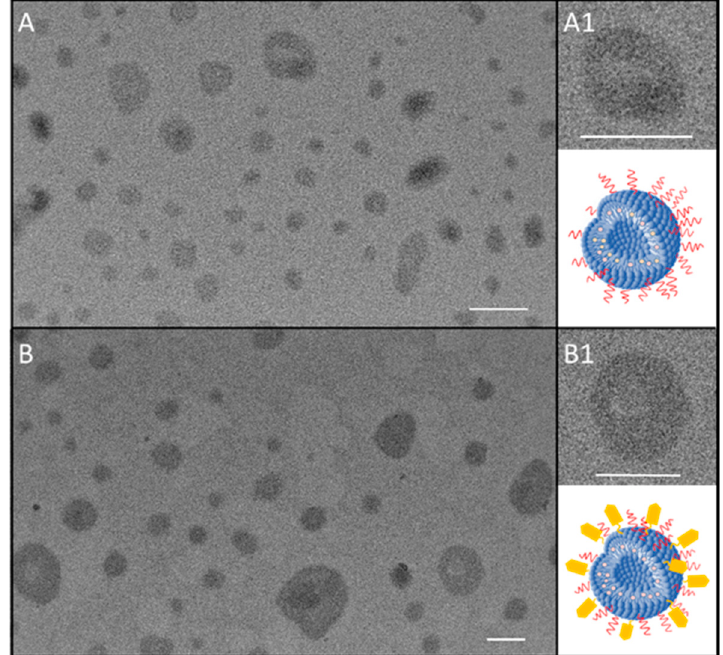
Figure 2. Representative transmission electron microscopy (TEM) micrograph of 5-FU/LPs ( A , A1 ) and anti-FZD10/5-FU/LPs ( B , B1 ). High magnification close-up of 5-FU/LPs ( A1 ) and anti-FZD10/5-FU/LPs ( B1 ) along with the corresponding sketch. Scale bar 100 nm.